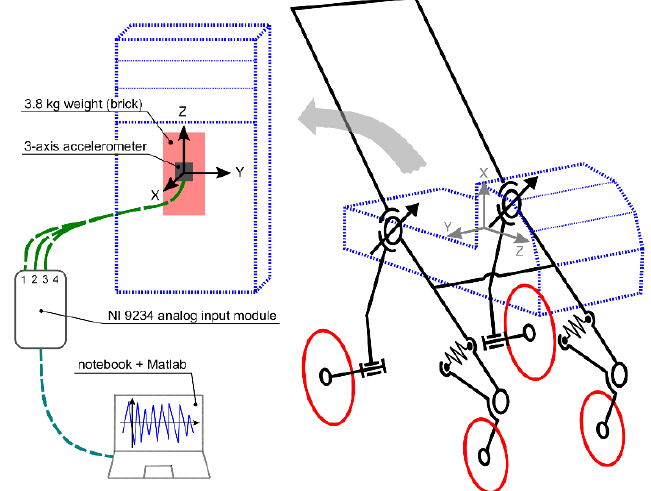
Figure 3. Schematic diagram of the research subject.